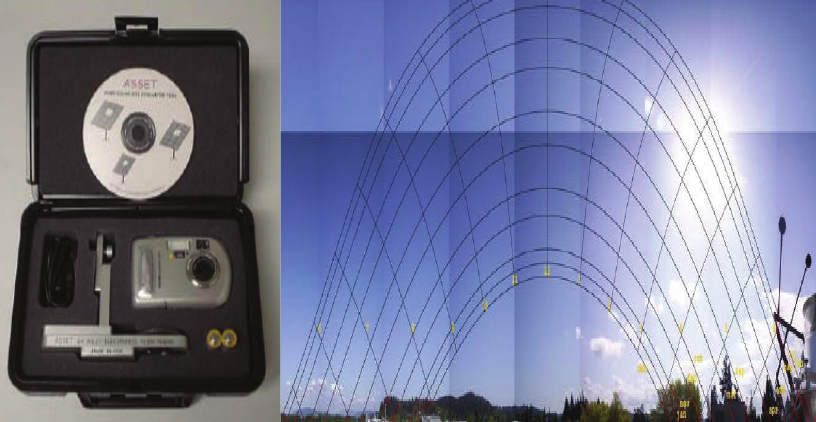
Figure 2: The Asset tools and series of the 9 × 1 pictures taken by them (photo courtesy of Solar Pathfinder).